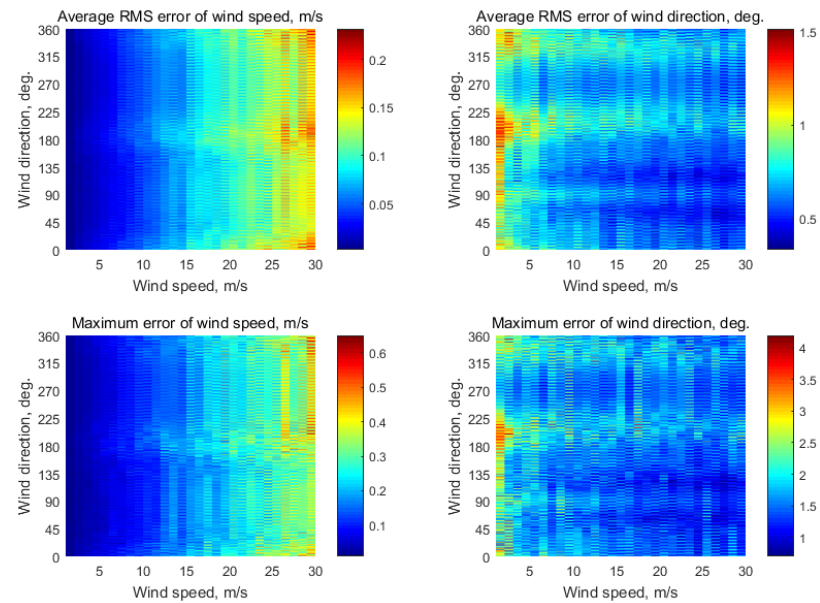
Figure A8. Semicircular wind retrieval results at a single 60° incidence angle.